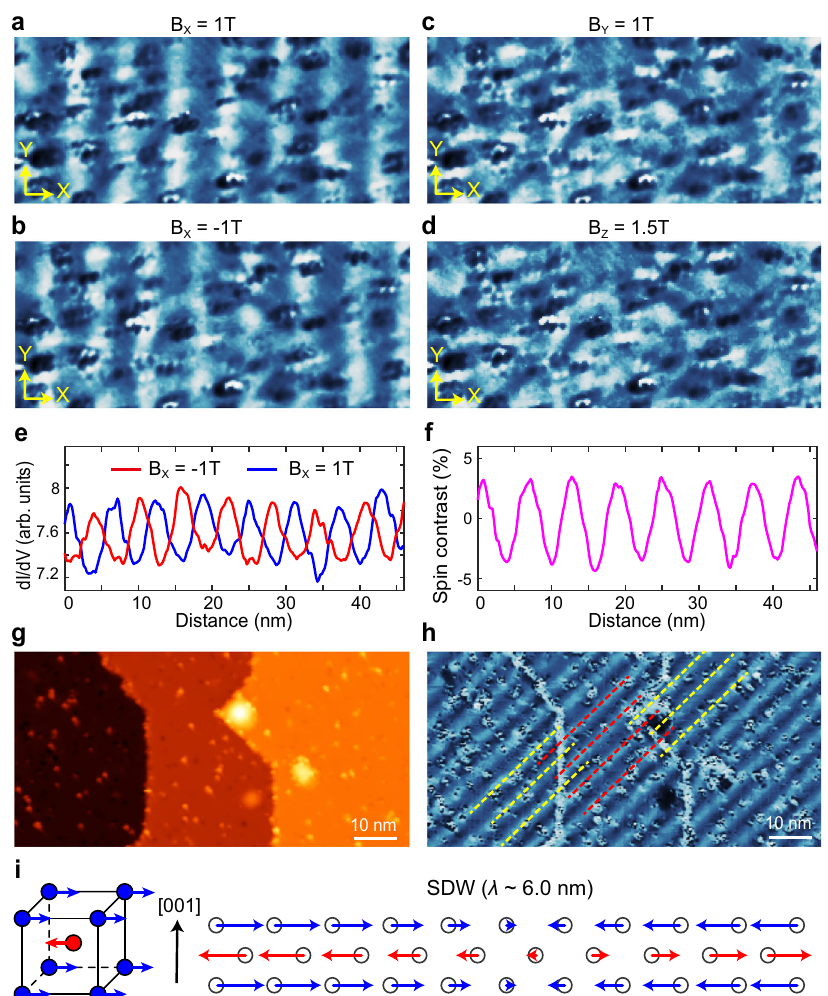
Fig. 3 Verifying the nature of spin density wave. a – d d I /d V maps taken with a Fe-coated tip under different magnet fi eld (marked above each panel). The mapping area is the same for these panels (size: 46 × 20 nm 2 , V b = − 100 mV, I = 80 pA, Δ V = 10 mV). e averaged line pro fi le (along X direction) of a , b . A phase inversion can be clearly seen for B x = ±1 T. f Spin contrast (polarization ratio) calculated by the relative difference of the line pro fi les in e . g STM image of three adjacent mono-atomic steps. The step height is ≈ 1.45 Å. h d I /d V map taken in the same area of panel g , the SDW displays phase inversion across each step edge, as indicated by yellow and red dashed lines ( V b = − 200 mV, I = 100 pA, Δ V = 15 mV). i A sketch of local spin con fi guration and IC- SDW near Cr (001)